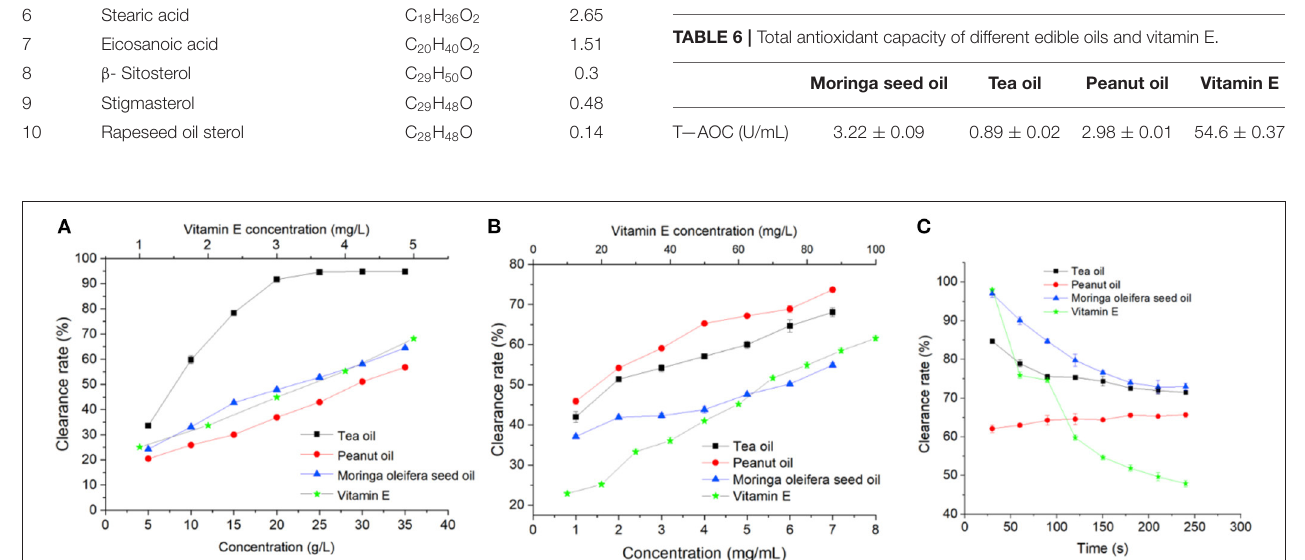
FIGURE 4 | Antioxidant activities of Moringa seed oil, tea oil, peanut oil, and vitamin E: (A) DPPH free radical scavenging assay, (B) hydroxyl radical scavenging assay, and (C) superoxide radical (O2 · -) scavenging activity assay. Data were expressed as mean ± SD.